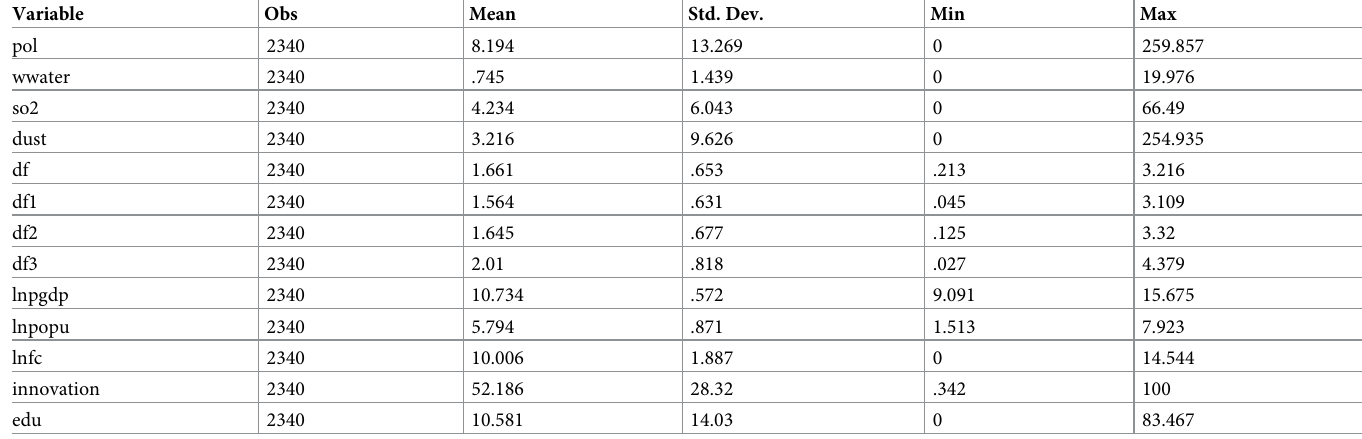
Table 2. Descriptive statistics of